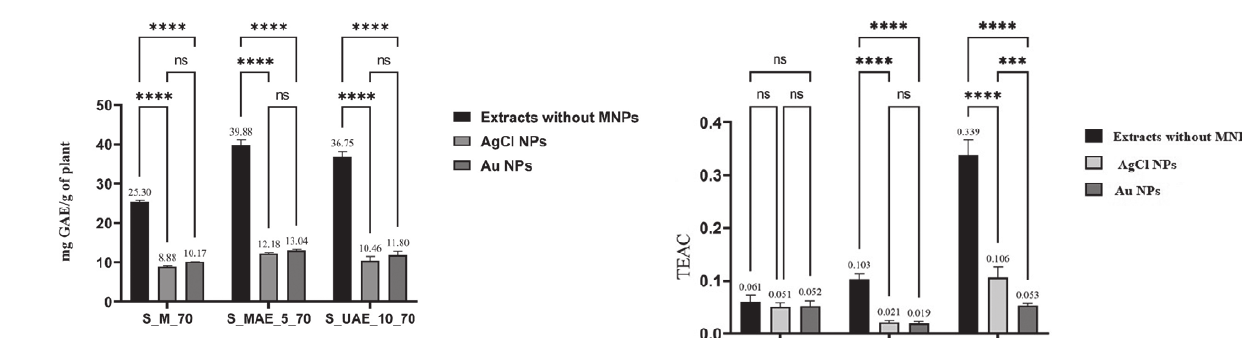
Figure 4. Total polyphenols content of simple extracts and nano- structured phytochemical complexes of S. officinalis (Data are expressed as mean ± SD values from independent triplicate experi- ments and p values were calculated by one-way ANOVA followed by Šídák’s multiple comparisons test; ****p < 0.0001; ns p = 0.1310; 0.1497;